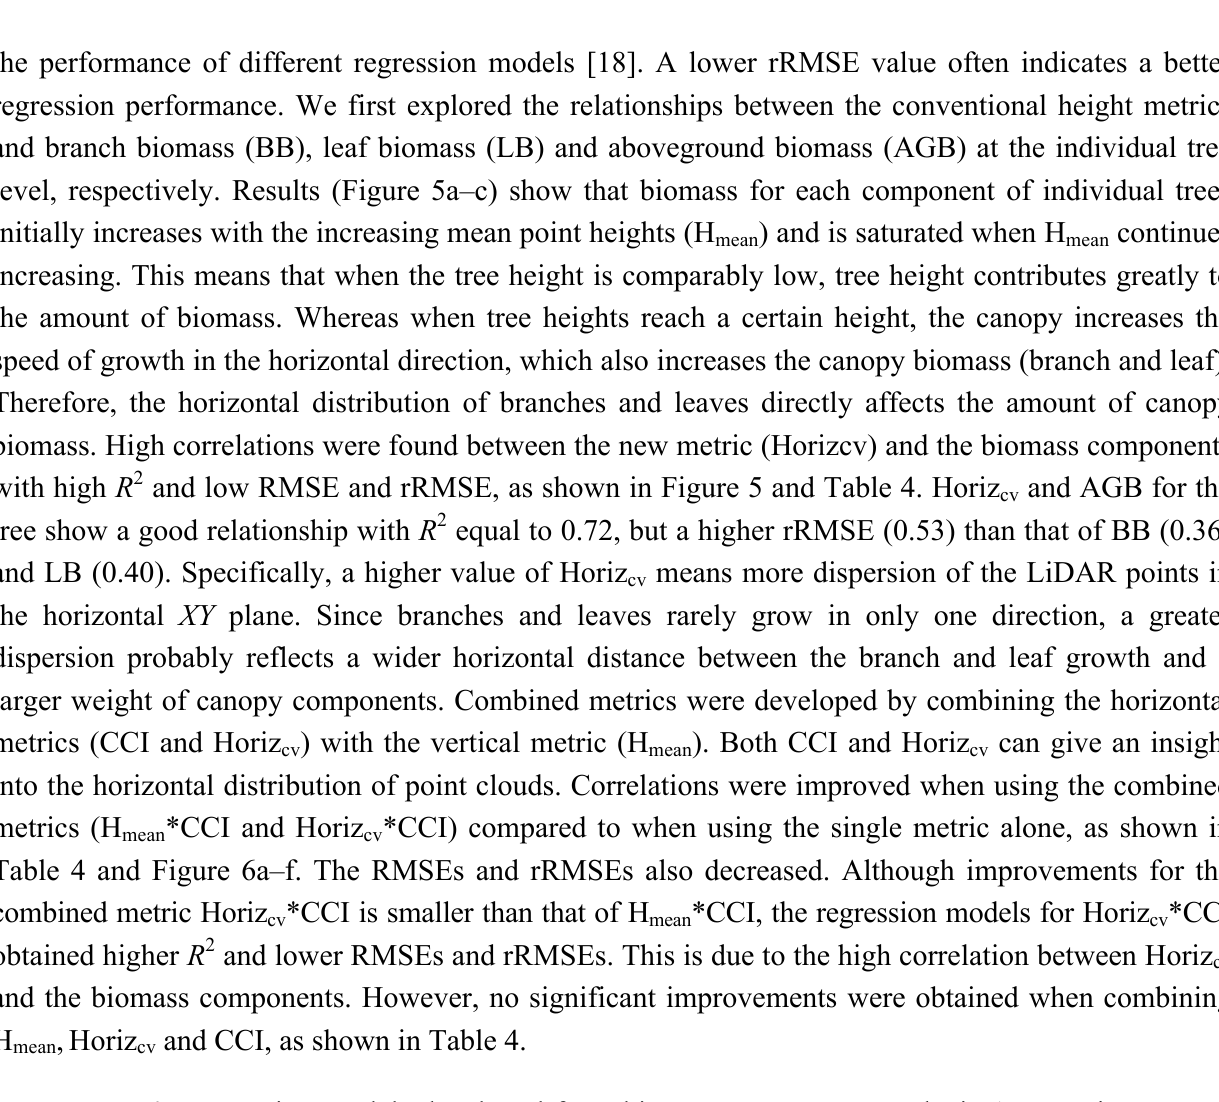
Table 4. Regression models developed from biomass components and LiDAR metrics at the tree